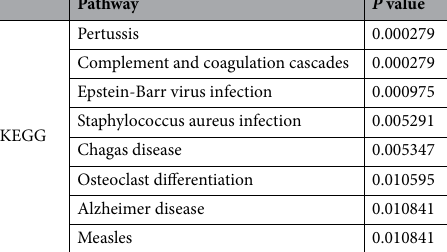
Table 4. KEGG analysis of co-DEGs.